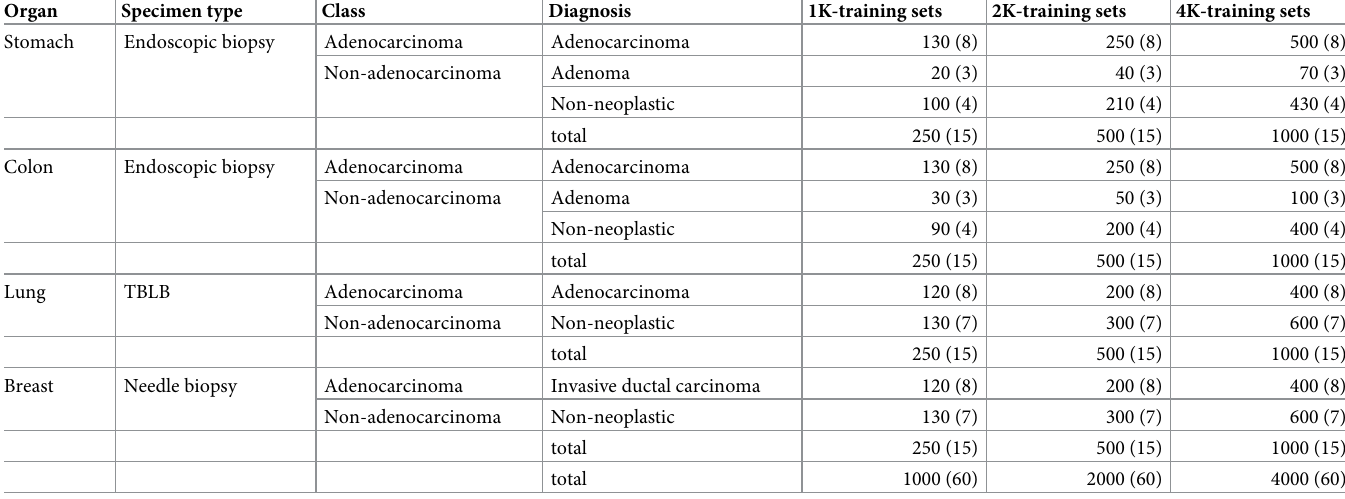
Table 2. Distribution of cases in the training sets and validation sets. The numbers of validation cases are given in parentheses. Organ Specimen